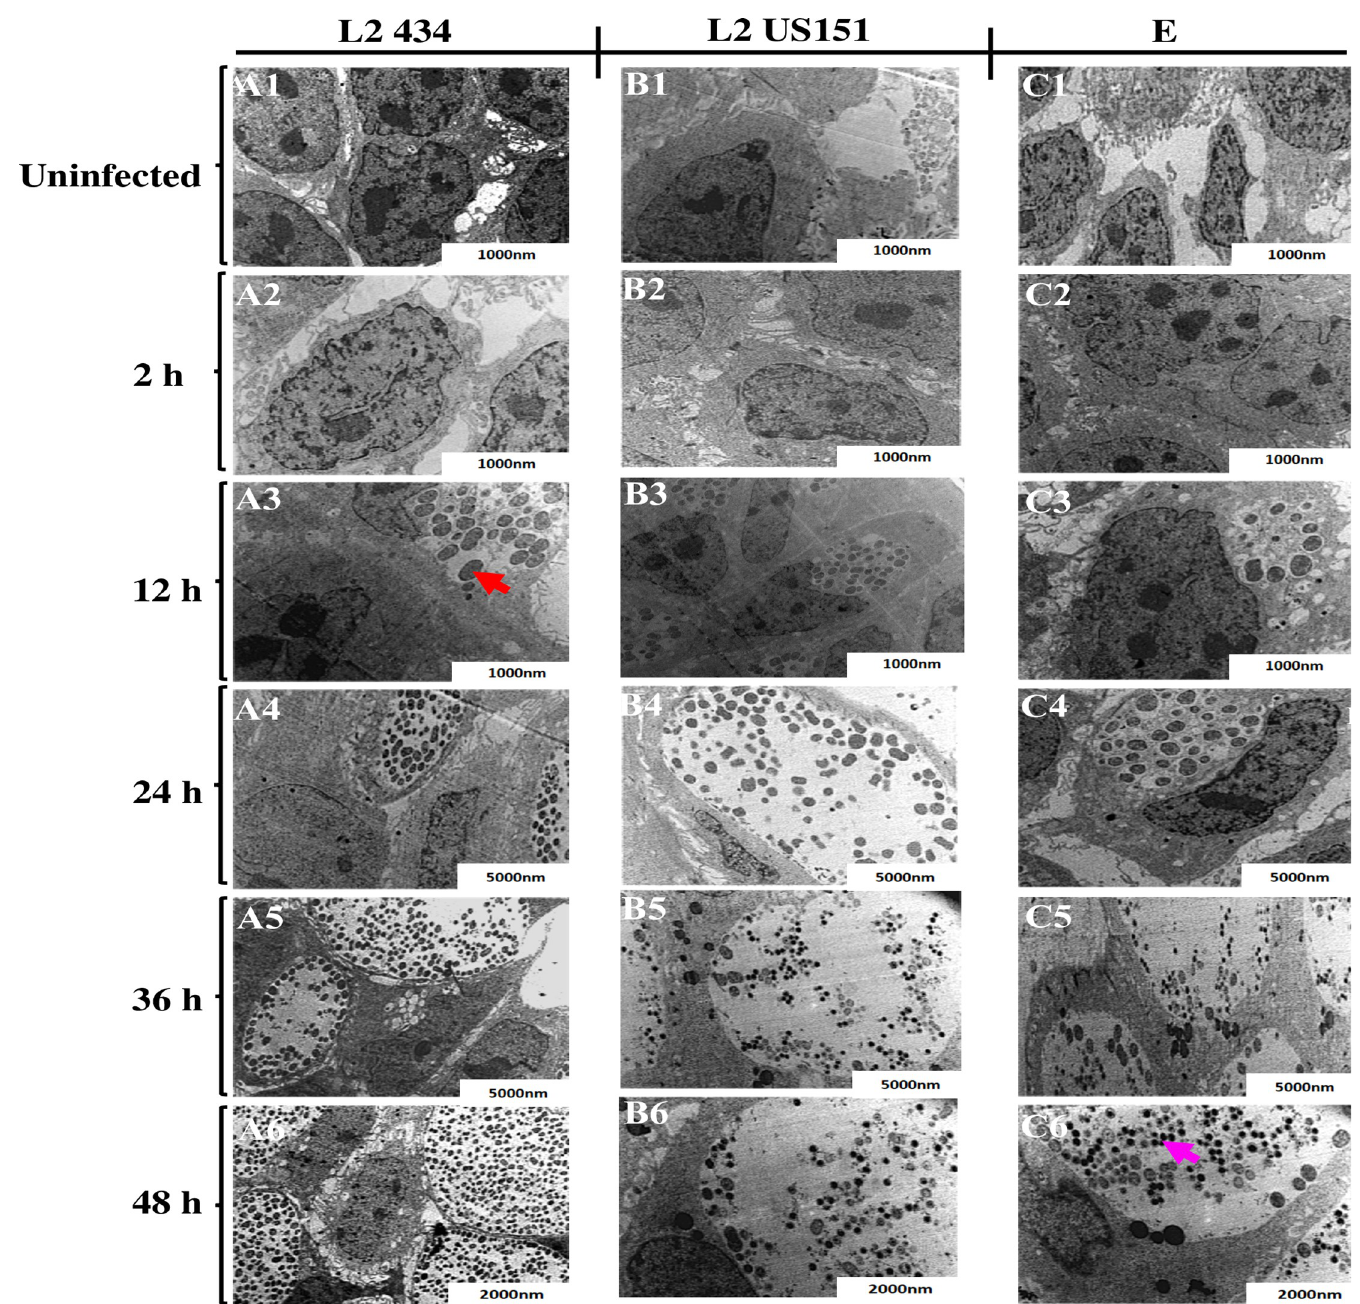
Fig 3. TEM micrographs of HaCaT cells infected with C . trachomatis reference strain L2 434, clinical isolates US151, and serovar E demonstrating differentiation, growth, division and redifferentiation at 37˚C over the course of the developmental cycle. Panel A1, B1 and C1 show micrographs of uninfected HaCaT cells (negative controls), A2, B2 and C2 at 2 hpi, A3, B3 and C3 at 12 hpi, A4, B4 and C4 at 24 hpi, A5, B5 and C5 at 36 hpi, A6, B6 and C6 at 48 hpi. Cultures were infected at an MOI of 10. Red arrowhead point at RB and pink arrowhead point at EB compartmentalized within the inclusions. of gene expression observed for strain E could be correlated with the fact that the primary tar- get for genital serovars are epithelial cells of the genital tract, and in this study, keratinocytes were used.